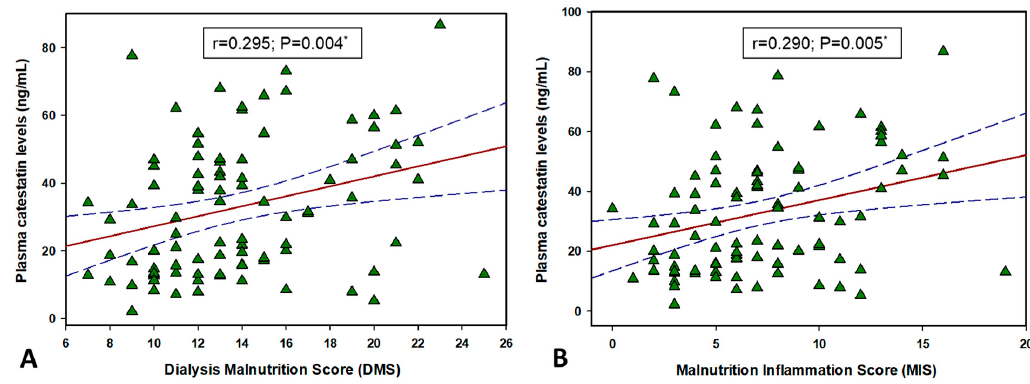
Figure 5. Correlation between CST levels and Dialysis Malnutrition Score ( A ) and Malnutrition-Inflammation Score ( B ) in hemolysis patients (N = 91). *, solid red line represents Pearson’s correlation coefficient, while blue lines represent 95% confidence intervals.